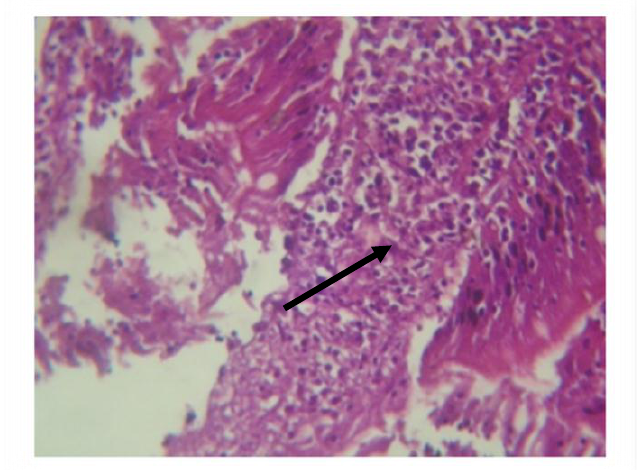
Figure5: Histopathological section of spleen 14day post infection show congestion with hemosiderin dipposites (H&E40×).